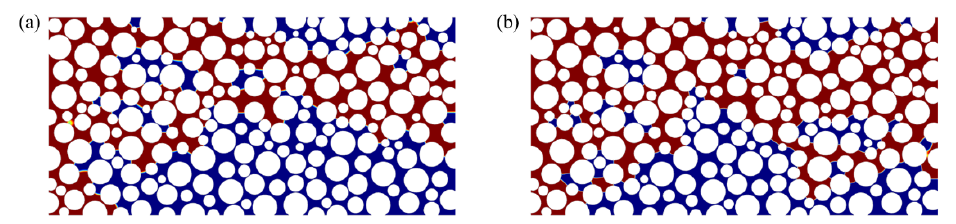
Figure 16. CO 2 saturation distribution under different interfacial tension. Red and blue regions represent CO 2 and oil, respectively. ( a ) σ = 0.025 N/m; ( b ) σ = 0.01 N/m.